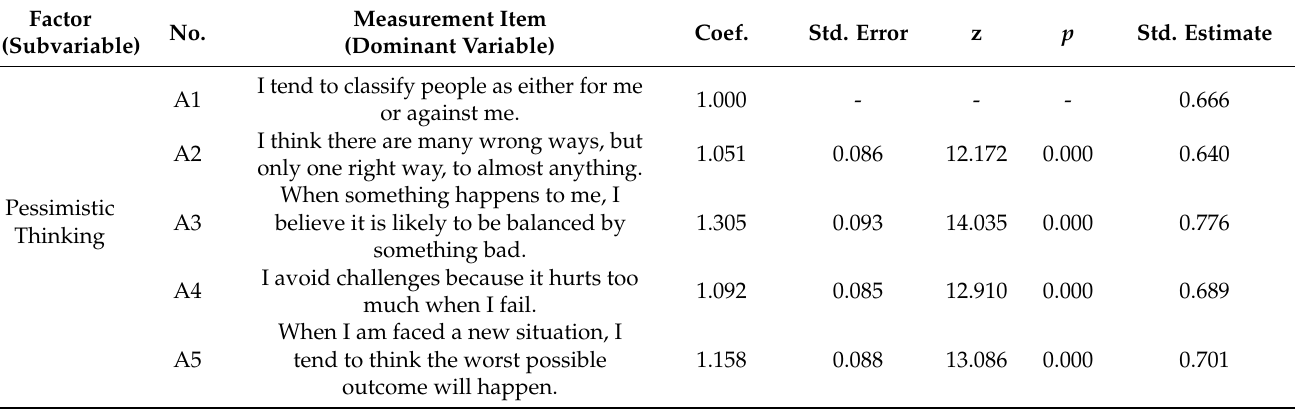
Table 7. Table of factor loading